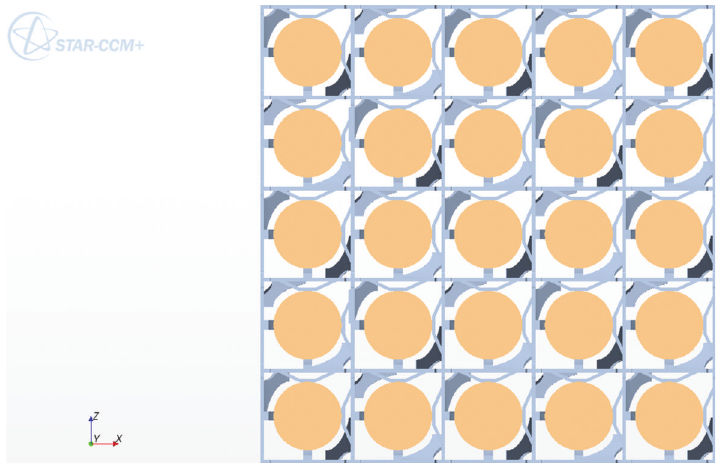
Figure 4: Contacts between rods and spacers.